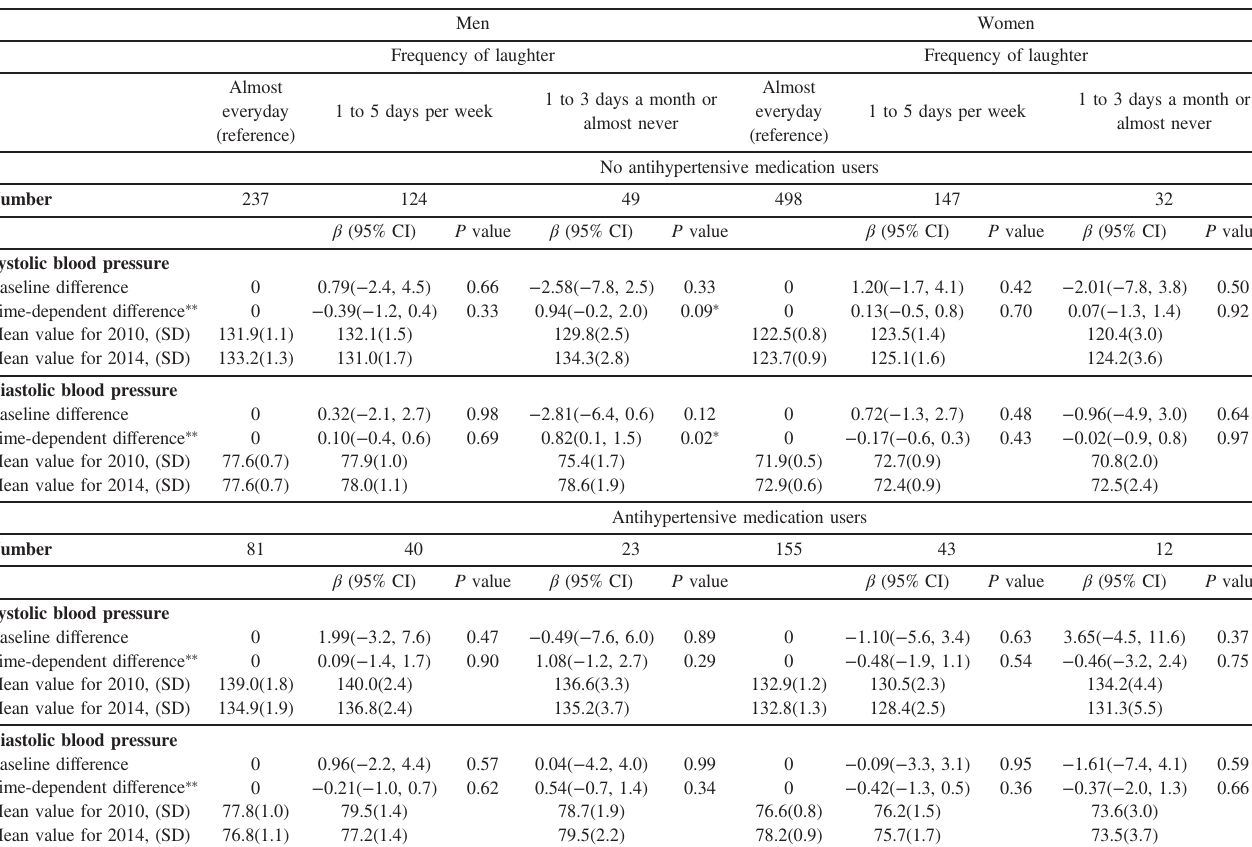
Table 3. Sex-speci fi c changes in systolic and diastolic blood pressures with time by the frequency of laughter in everyday life with and without antihypertensive medication